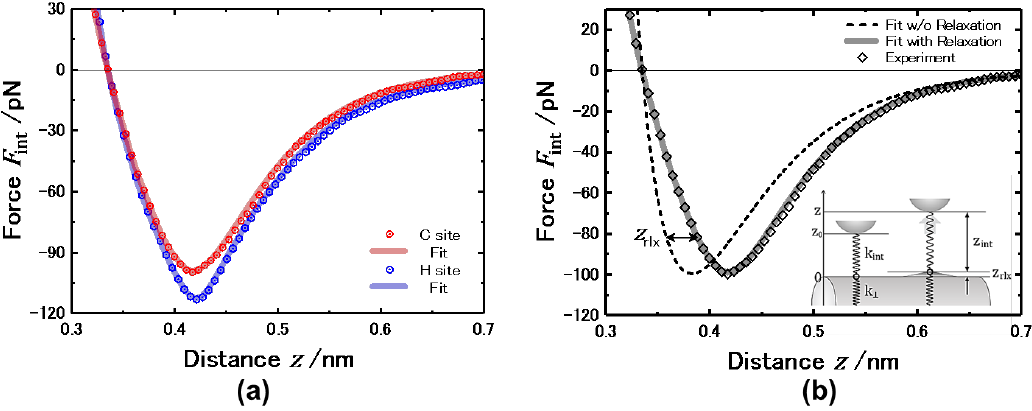
Figure 3. ( a ) Interatomic force F int vs. vertical distance z relationship at atomically specific C and H sites over the topmost part of convexly curved graphene. The C and H sites are respectively corresponding to the atomically specific sites representing depressing and protruding features in the topography image (i.e., the lower panel in Figure 2a) obtained during the 3D-FFS measurement. The interatomic forces F int obtained at those sites were respectively averaged and plotted with the simulation curves (solid lines). ( b ) The relationship between the simulation curves of solid and dashed lines obtained with and without taking relaxation into account, respectively. Those simulation curves are drawn together with the experimental-data plots obtained at the C site. The out-of-plane relaxation of the closest carbon atom due to the interatomic attractive force acting to the tip-apex atom is schematically illustrated in the inset of (b).